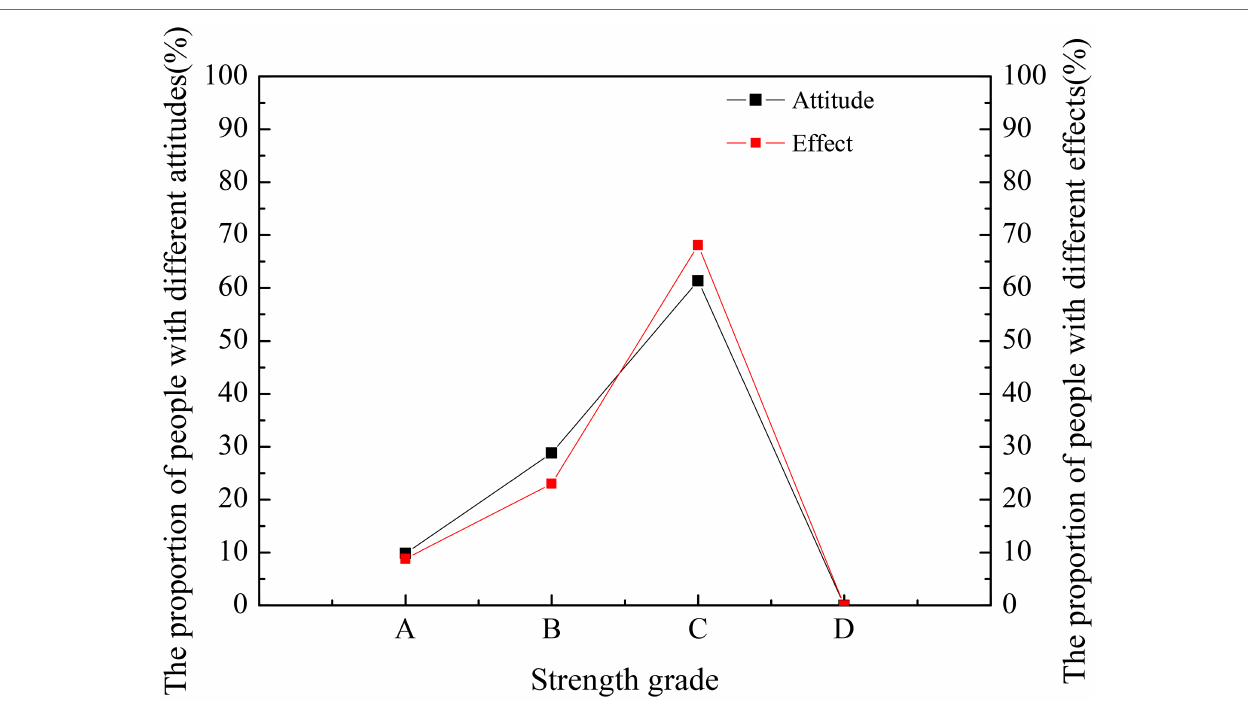
FIGURE 4 | Comparison of students’ attitudes and effects of entrepreneurship education in ideological and political